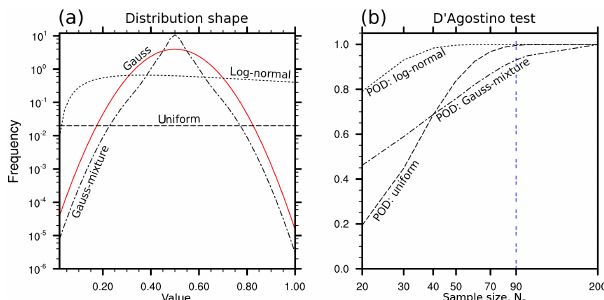
Figure 1. (a) Three non-Gaussian distributions on which PODs have been estimated: uniform distribution, log-normal distribution, and Gaussian mixture (see text for description). (b) POD for K 2 test. PODs are computed over N xp = 10 5 one-dimensional experi- ments for different sample sizes N s